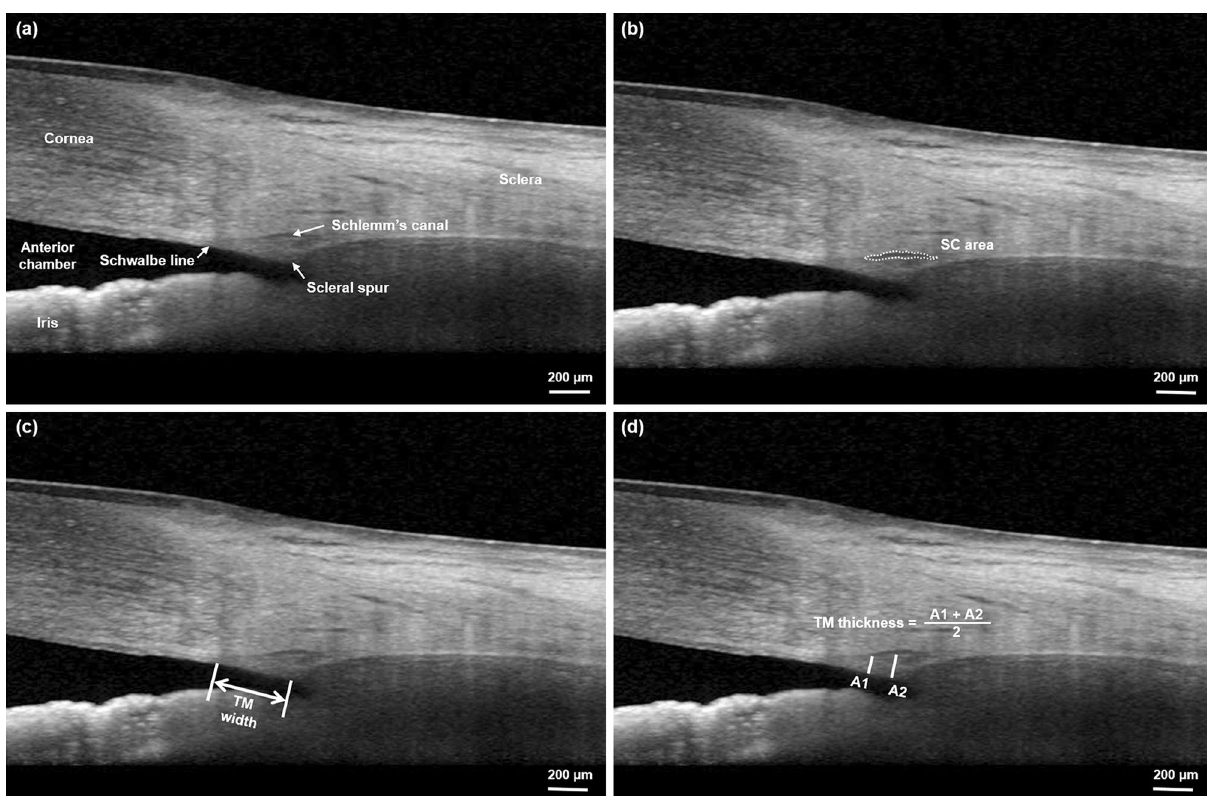
Figure 2. Measurements of the trabecular meshwork (TM) width, TM thickness, and Schlemm’s canal (SC) area. ( a ) The enhanced depth imaging optical coherence tomography B-scan was used to measure the parameters. ( b ) The black oval space was identified as SC and its area was measured by manually delineating the SC lumen. ( c ) The TM width was defined as the distance from the scleral spur to the Schwalbe line. ( d ) The thickness of TM was calculated as the average of two measurements, the perpendicular distances from the anterior endpoint (A1) and midpoint (A2) of SC to the inner layer of the